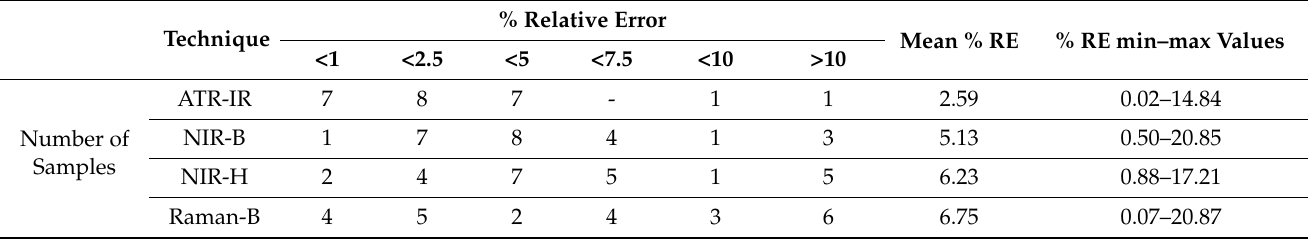
Table 3. Summary of PLSR accuracy obtained with all